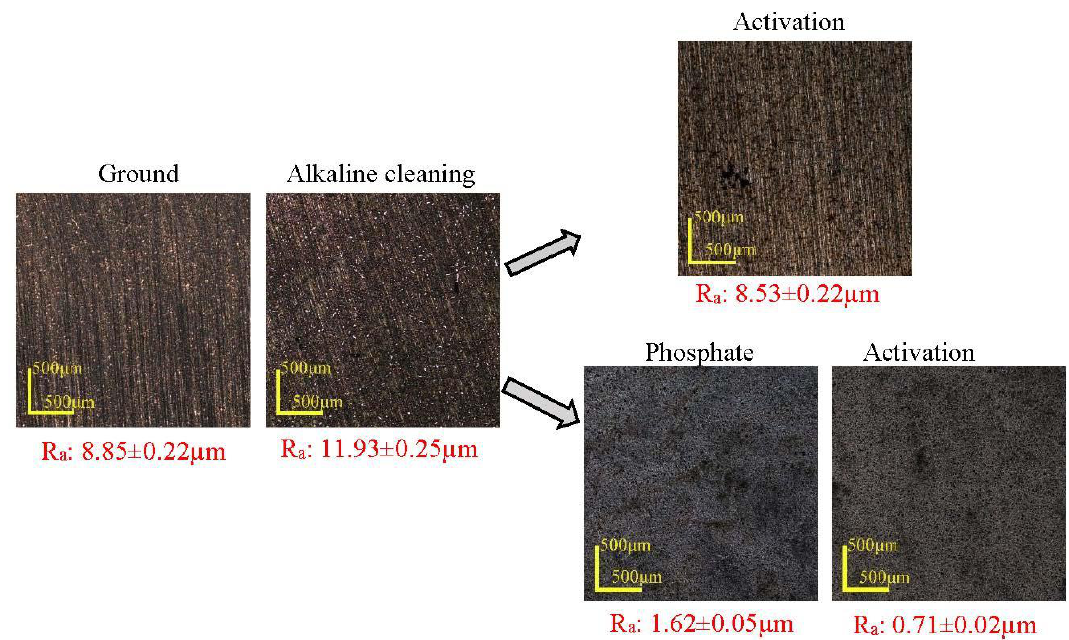
Figure 1. Representative Laser Scanning Confocal Microscopy images showing the sample surface after each pre-treatment step.